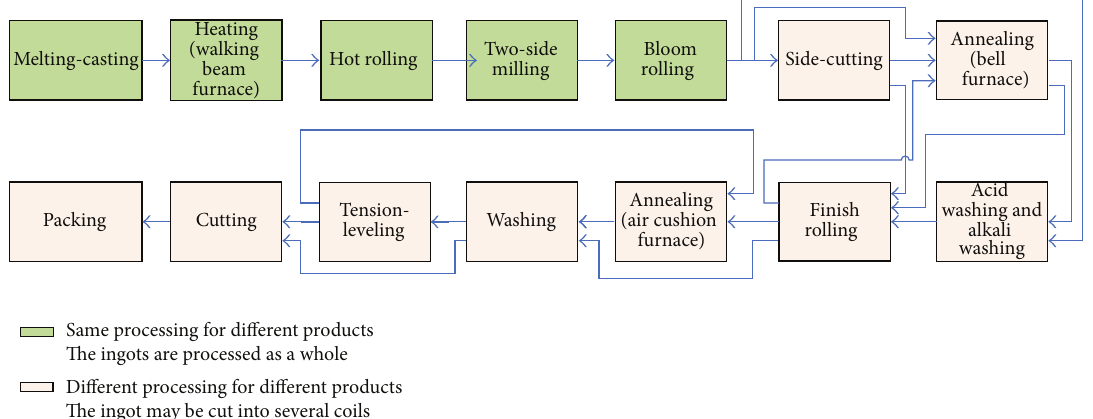
Figure 1: Technological process for copper alloy strip production.